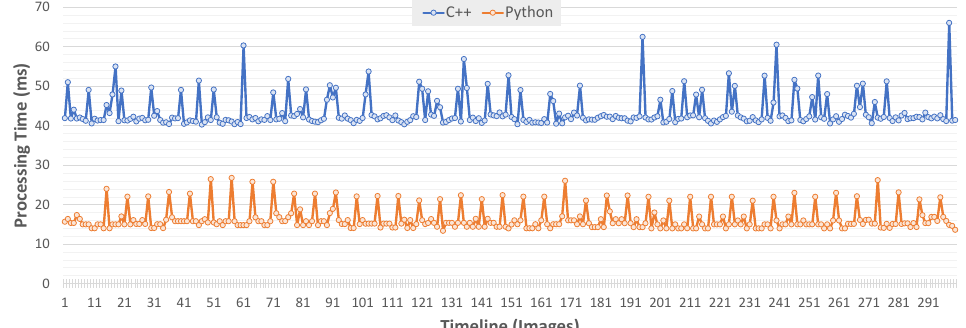
Figure 11. Complete processing times of the colour and face detection algorithms in C++ and Python. For C++ DLL: average, 43.38 ms; minimum, 40.30 ms; maximum, 66.08 ms. For Python MQTT: average, 16.30 ms; minimum, 13.41 ms; maximum, 26.82 ms.